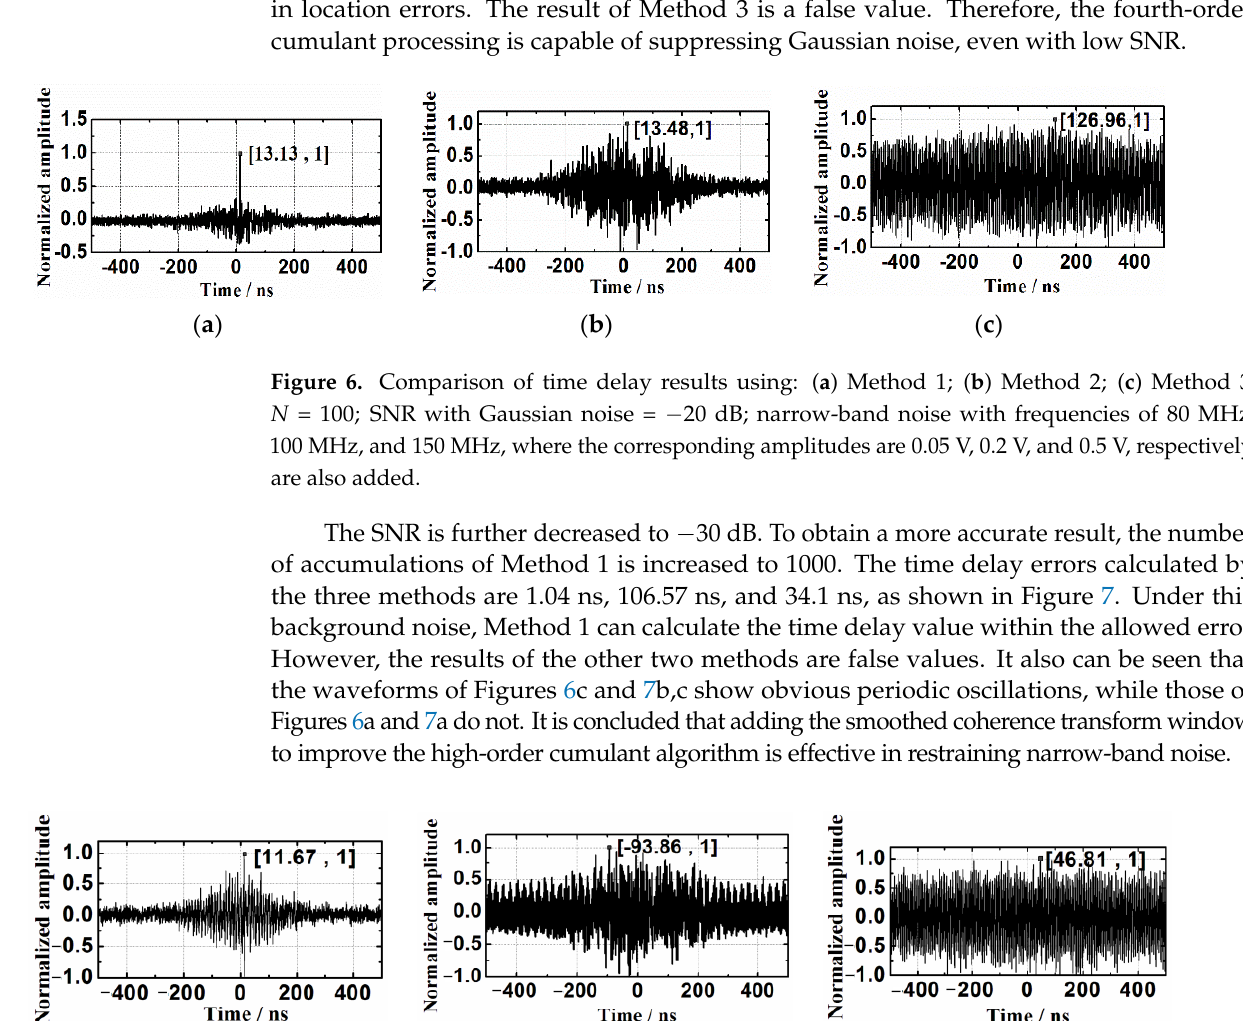
Figure 5. Comparison of time delay results using: ( a ) Method 1; ( b ) Method 2; ( c ) Method 3. N = 10, SNR with Gaussian noise = 10 dB. N is the number of accumulations.